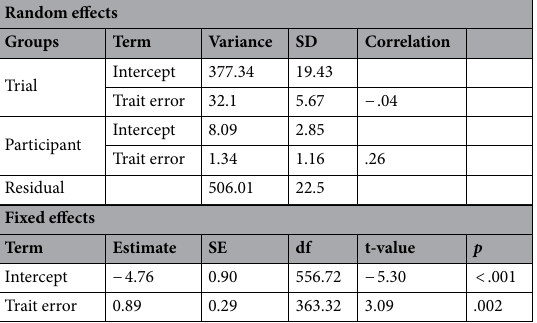
Table 1. Model summary for predicting error of mental state inferences.